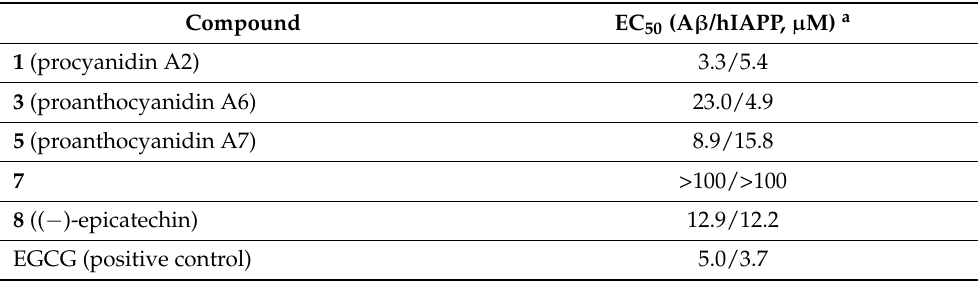
Figure 6. Efficacy of compounds 1 , 3 , 7, and 8 against pre-existing A β 42 aggregates. Aggregates of A β 42 (25 µ M) were monitored by Th-T fluorescence with varying concentrations of these compounds. ( A ) 1 , ( B ) 3 , ( C ) 7 , and ( D ) 8 . At an excitation wavelength of 420 nm and an emission wavelength of 485 nm, fluorescence intensity was measured. Each value is represented the mean ± SD ( n = 6). Table 2. Efficacy of compounds 1 , 3 , 5 , 7 , and 8 against pre-existing A β 42 and hIAPP aggregates.